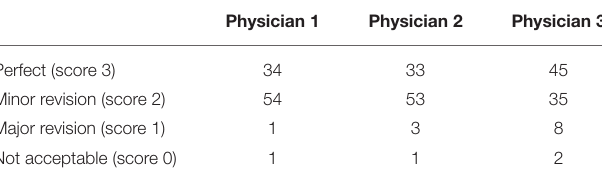
TABLE 5 | Clinical evaluation 1.